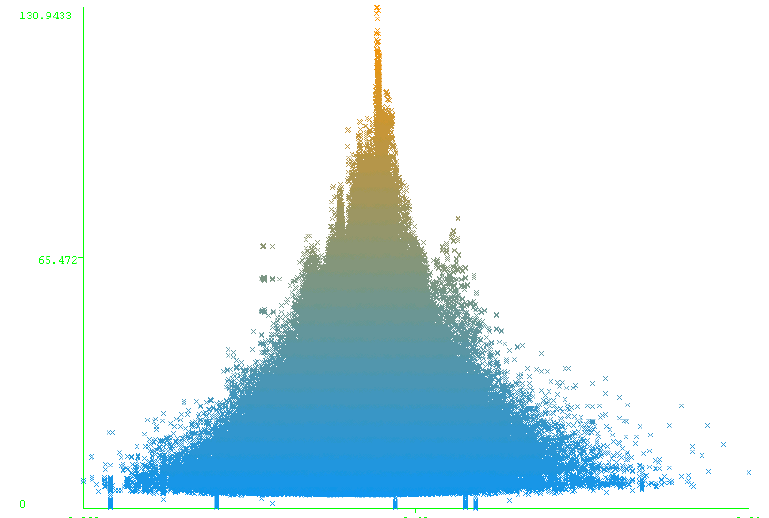
Figure 3: Distance distribution of property WILM950104. The x-axis represents the normalized value of the physicochemical property and the y-axis represents the distance between amino acids.